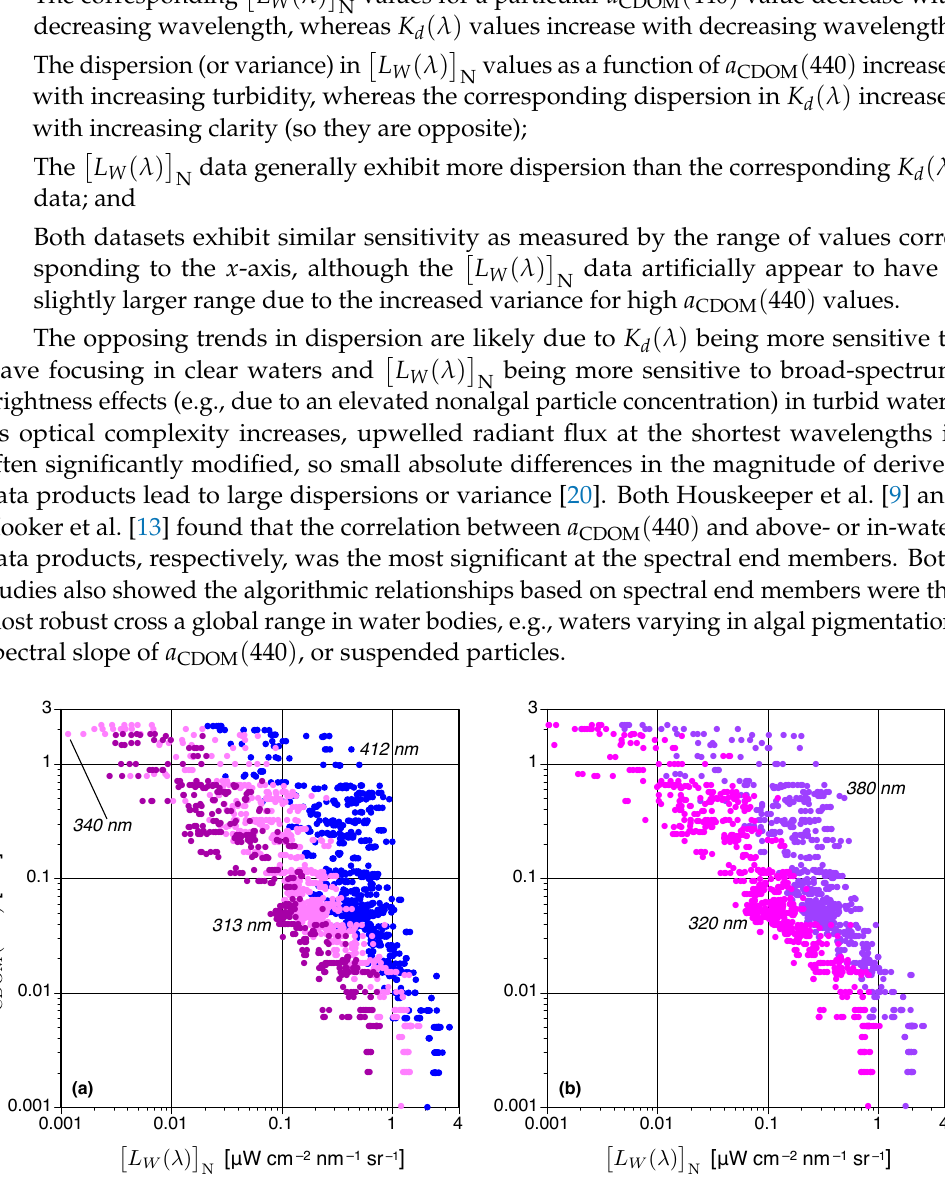
Figure 4. The in situ observations for the one-band C-OPS a CDOM ( 440 ) emphasizing a next-generation (UV) and legacy (blue domain) perspective: ( a ) the data for 313, 340, and 412nm (left panel), and ( b ) the data for 320, and 380nm (right panel). The median efficacies of the final one-band